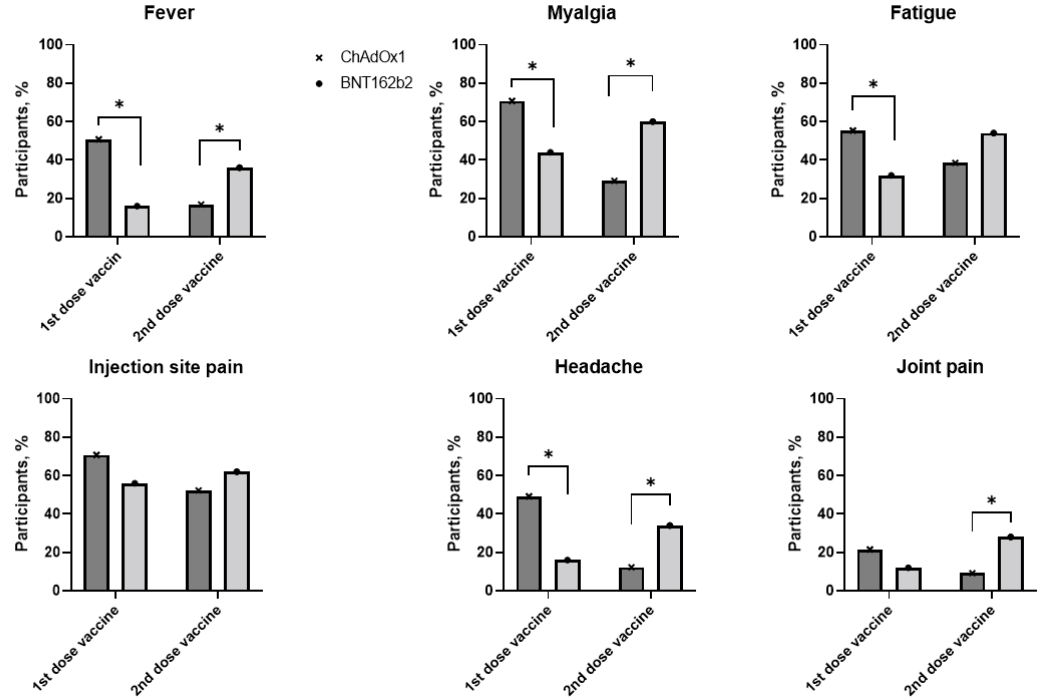
Figure 3. Most commonly reported adverse events after the first and second doses in ChAdOx1 and BNT162b2 groups. * p value < 0.05 when comparing frequencies of adverse events between ChAdOx1 and BNT162b2 groups.